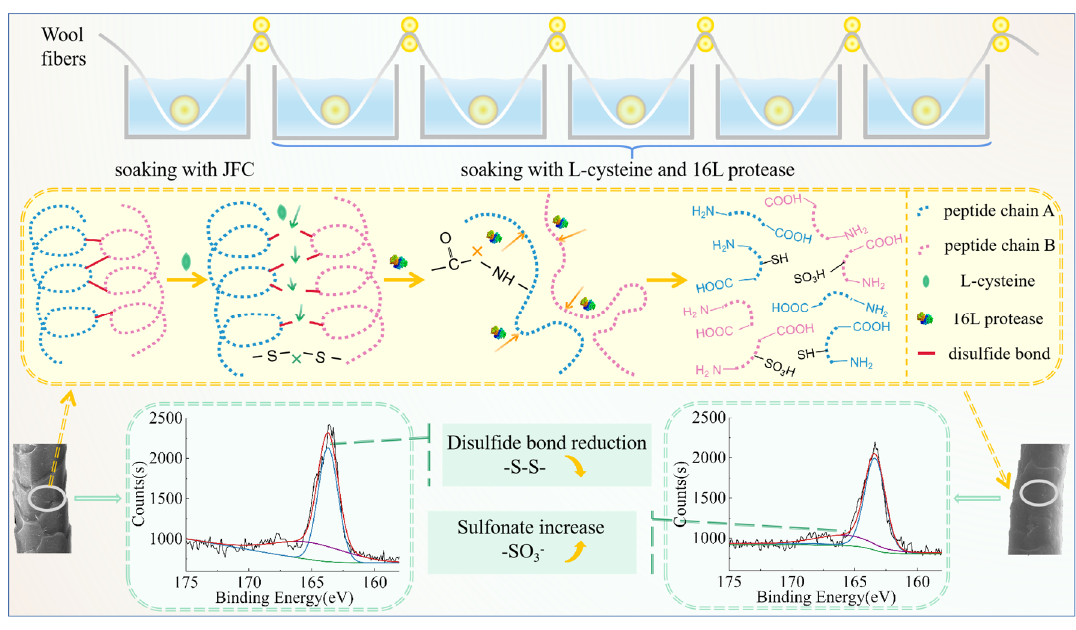
Figure 1. Schematic diagram showing the technological process and reaction mechanism of shrink- proof finishing with